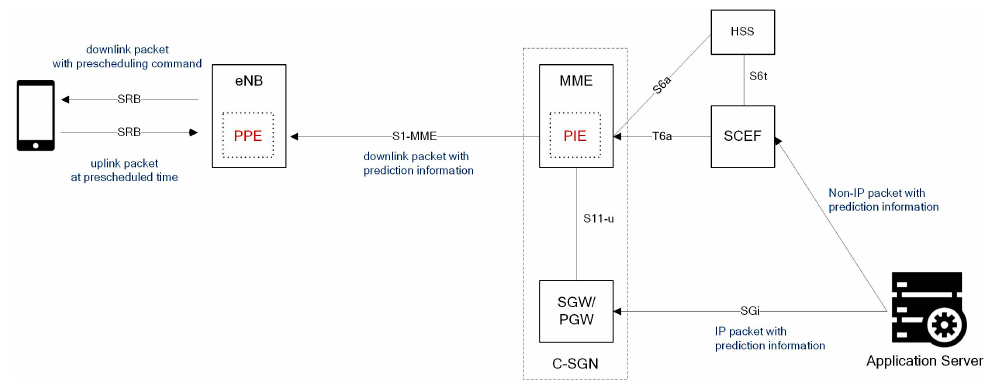
Figure 11. Network architecture with prediction-based energy saving mechanism (PBESM).